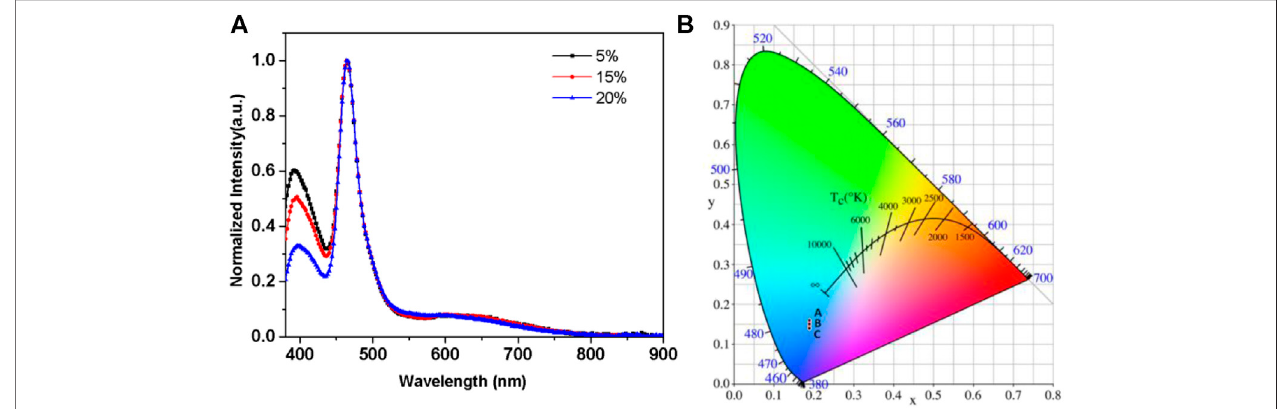
FIGURE 3 | (A) The normalized EL spectra of devices and (B) the chromaticity coordinates of devices.